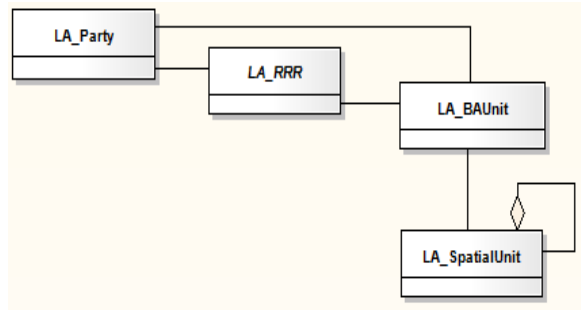
Figure 1. LADM core classes (ISO, 2012) Figure 2. Definition of Oid value type (ISO, 2012)